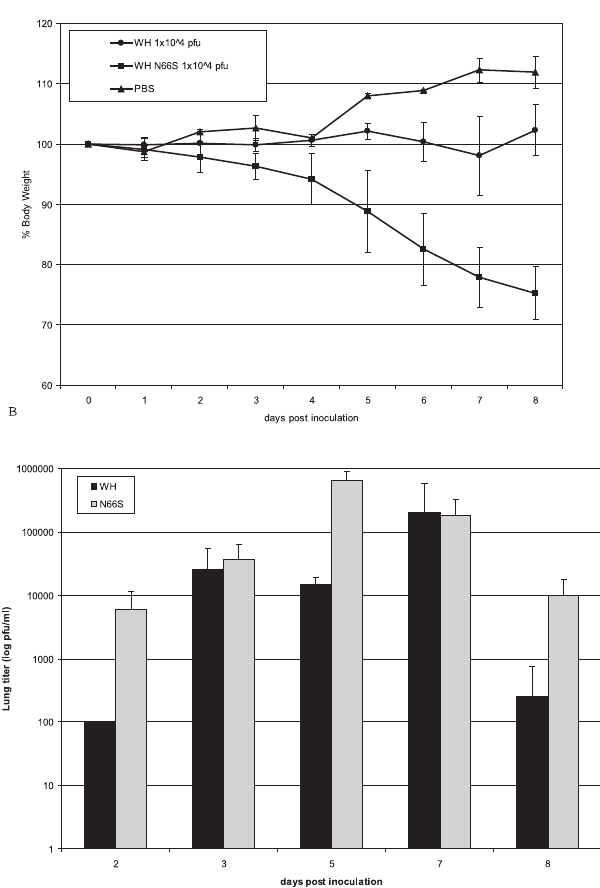
Figure 3. Contribution of PB1-F2 N66S Mutation to Pathogenicity of Recombinant Virus (A) Mice were inoculated with 1 3 10 4 PFU of virus or PBS, and their weights were recorded every day after infection. (B) Virus titers from lung homogenates were measured from mice infected with WH or WH N66S virus at days 1, 2, 3, 5, 7, and 8 after inoculation. Error bars represent 1 standard deviation.